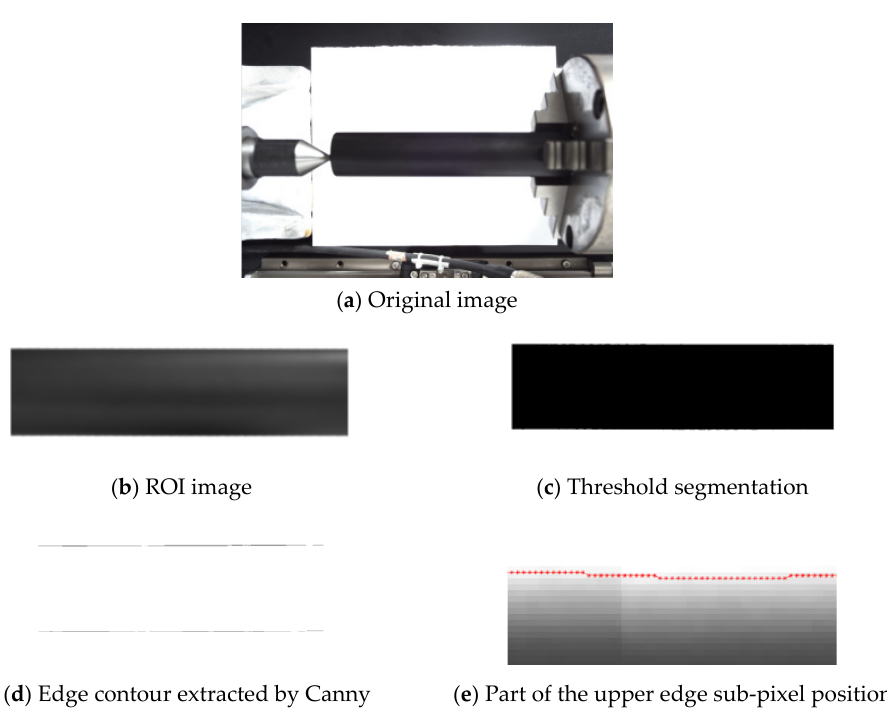
Figure 16. Images after image processing.